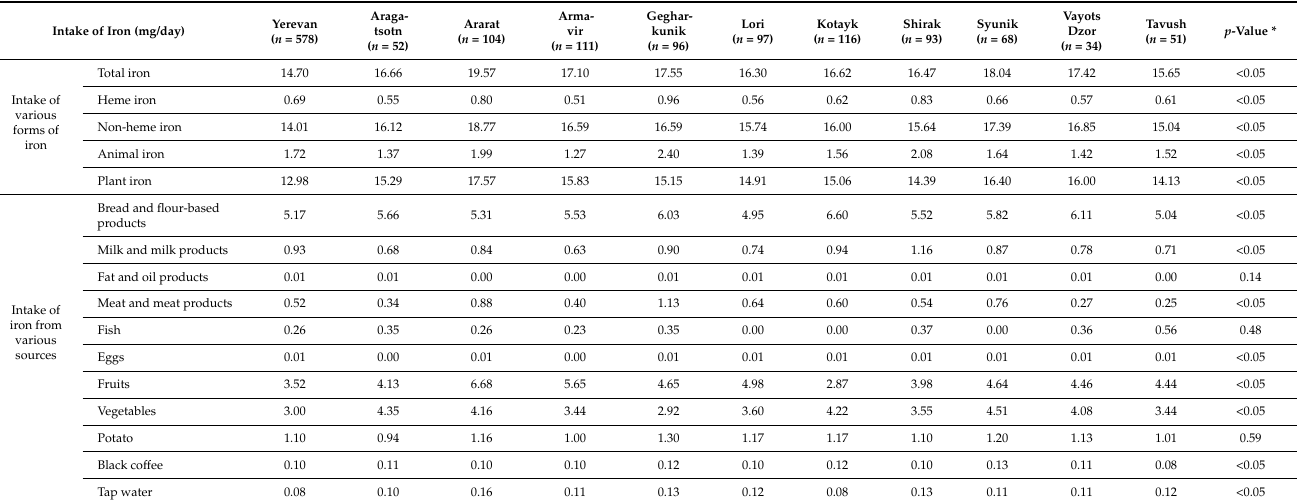
Table 3. Comparison of intake of various forms of iron along with that of iron intake from various sources in the national sample of Armenian adults from all the regions.